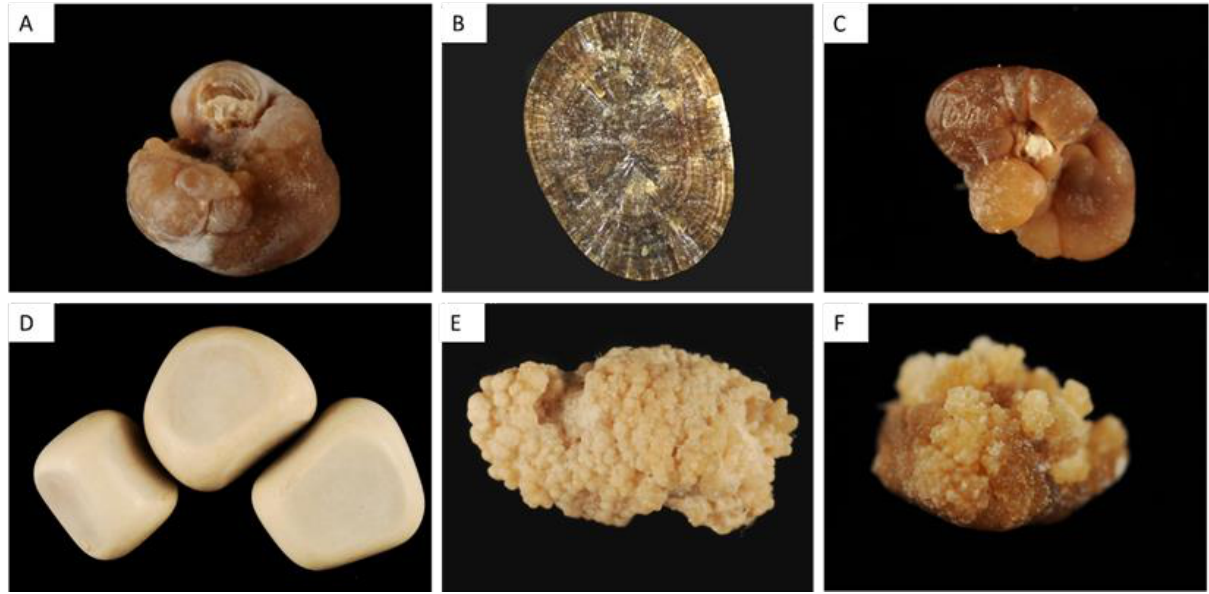
Figure 1. Type I stones, made of calcium oxalate monohydrate. ( A ) Type Ia stone exhibiting a papillary umbilication. The gray veil on stone surface indicates recent crystalline deposits, i.e., stone activity. ( B ) Type Ia stone section showing a concentric and radial organization. ( C ) Type Ia stone with a Randall’s plaque remnant (the whitish deposit in the umbilication). ( D ) Type Id stones, with a smoothened aspect due to stasis and chronic contact with other stones. ( E )Type Ic stone with a typical whitish and budding structure, due to primary hyperoxaluria. ( F ) type Ie stone, due to enteric hyperoxaluria.